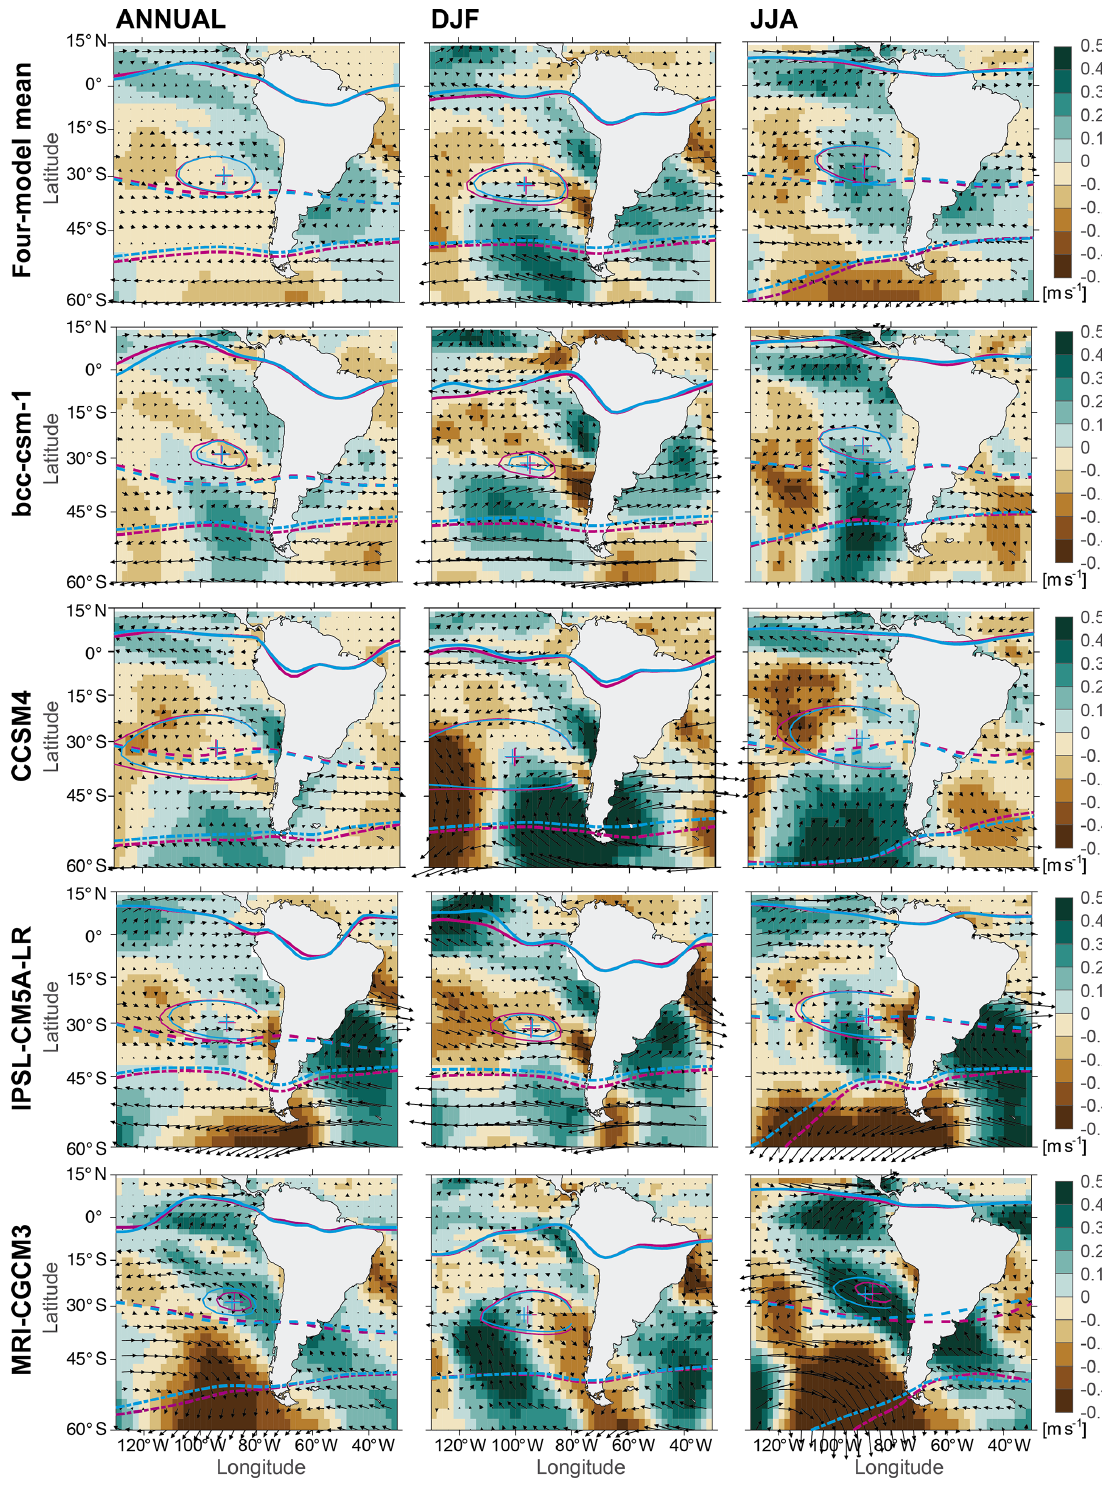
Figure 3. Annual and seasonal means of the southwestern South American climate system during the LIA (cyan lines) and the CWP (fuchsia lines) for the four-model mean and for each model. Background colors and vectors show the meridional wind difference LIA minus CWP. DJF: austral summer, JJA: austral winter, ITCZ: Intertropical Convergence Zone (thick solid lines), SPSH: Subtropical South Pacific High (thin solid lines), STJ: subtropical jet (dashed lines), SWW: southern westerly winds (dash-dotted lines). Crosses indicate the location of maximum SLP over the SPSH (i.e., SPSH